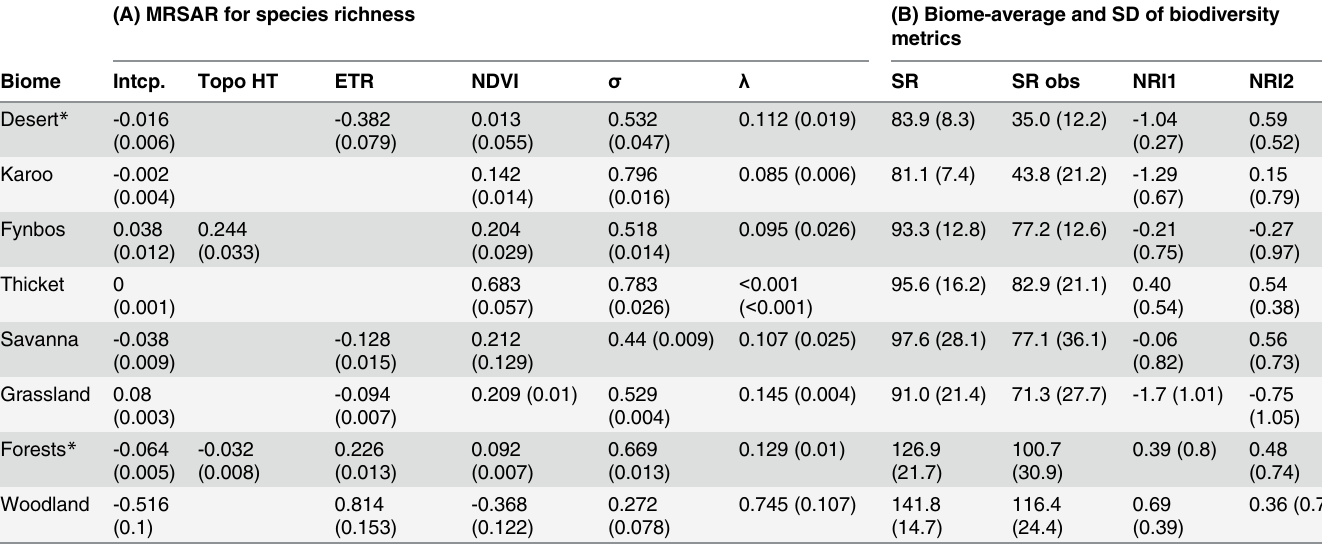
Table 1. (A) Biome-specific spatially auto-correlated regressions (MRSAR) of passerine species richness against elevational range in the grid cells (Topo HT; left blank if not selected in the final model), water availability (ETR increases with water availability; left blank if not selected in the final model), and primary productivity (NDVI increases with primary productivity). σ and λ respectively estimate the remaining variance and the auto- correlation coefficient. All variables were standardized to a mean of 0 and standard deviation of 1 before analysis. (B) Average and standard deviation of bio- diversity metrics (estimated and observed species richness, taxonomic dispersion under the two null models) for each